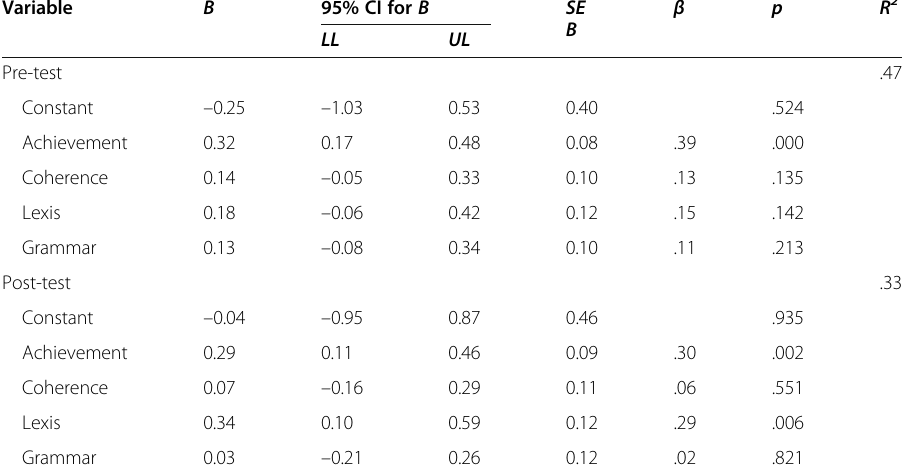
Table 3 Standard MR results